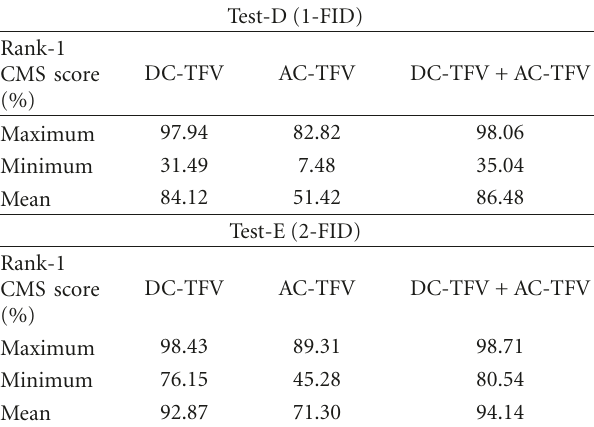
Table 4: Retrieval results of the FID